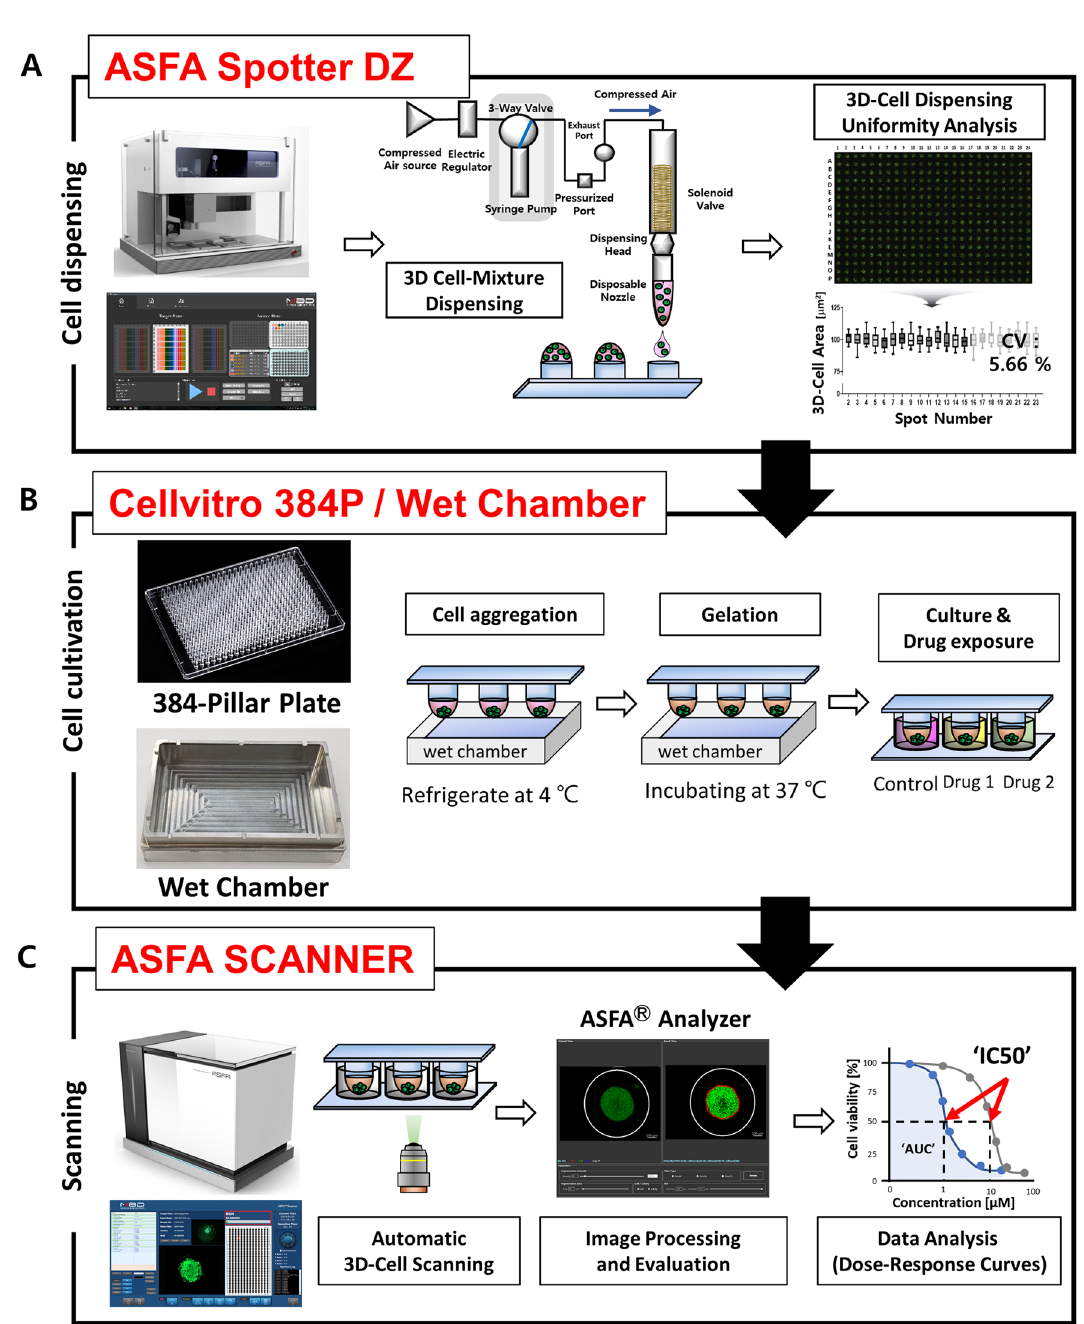
Figure 1. Schematic view of the 3D-Cell culture based high-throughput screening (HTS) platform for drug efficacy analysis in hepatocellular carcinoma (HCC) cells. ( A ) Schematic diagram of the sample dispensing and dispensing uniformity performance evaluation process using the proposed 3D-Cell spotter. ( B ). 384-Pillar plate photo and experimental procedure for 3D cell culture and drug efficacy test. ( C ). Quantitative analysis of drug efficacy using an automated optical scanner and image analysis (DRC) according to the concentration gradient (GraphPad Prism 9, GraphPad Software, CA). Based on the graph, the drug response to anticancer drugs was confirmed in individual cells through the quantified inhibitory concentration 50 (IC50) and area under curve (AUC) values (Fig. 1C). Cell Viability Assay For 2D‑HTS. For 2D-HTS analysis, HCC cell lines were mixed with fresh cell culture medium containing no ECM, and then samples prepared for 2D cell culture at a concentration of 2000 cells per 40uL volume were manually dispensed using a pipette. One day after seeding, using an ASFA Spotter DZ, drugs were dispensed in the same drug layout and concentration gradient as the 3D-HTS experimental conditions